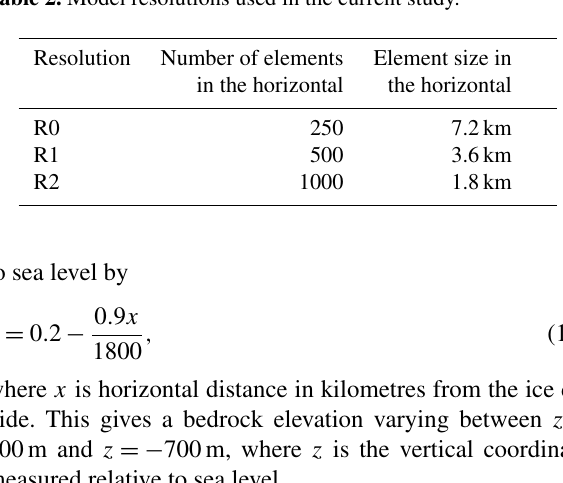
Table 2. Model resolutions used in the current